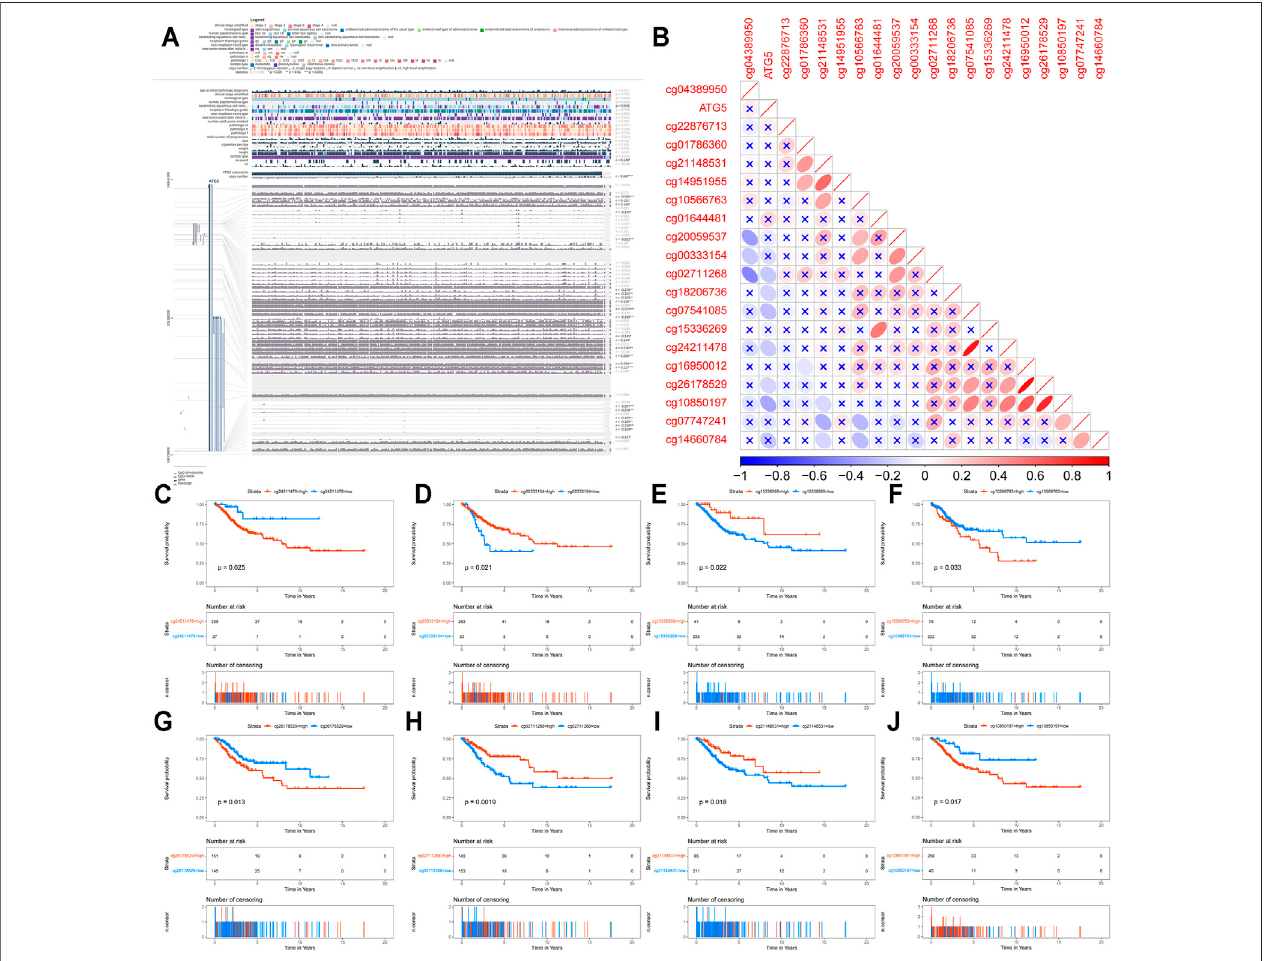
FIGURE 7 | Genomic methylation of ARGs in CESC (A) The methylation of ATG5 gene was signi fi cantly correlated with the OS in cervical cancer patients (B) The correlation between methylation sites of ATG5 and ATG5 expression in cervical cancer patients. Purple represents negative correlation; red represents positive correlation; “ × ” represents no statistical signi fi cance (C-J) Kaplan-Meier survival analysis showed the methylation sites of ATG5 signi fi cantly related to OS in cervical cancer patients ( p < 0.05). cg00333154, cg15336269, cg02711268, and cg21148531 located in ATG5 were bene fi cial for OS, while cg24211478, cg10566763, cg26178529, and cg10850197 located in ATG5 were harmful for OS.